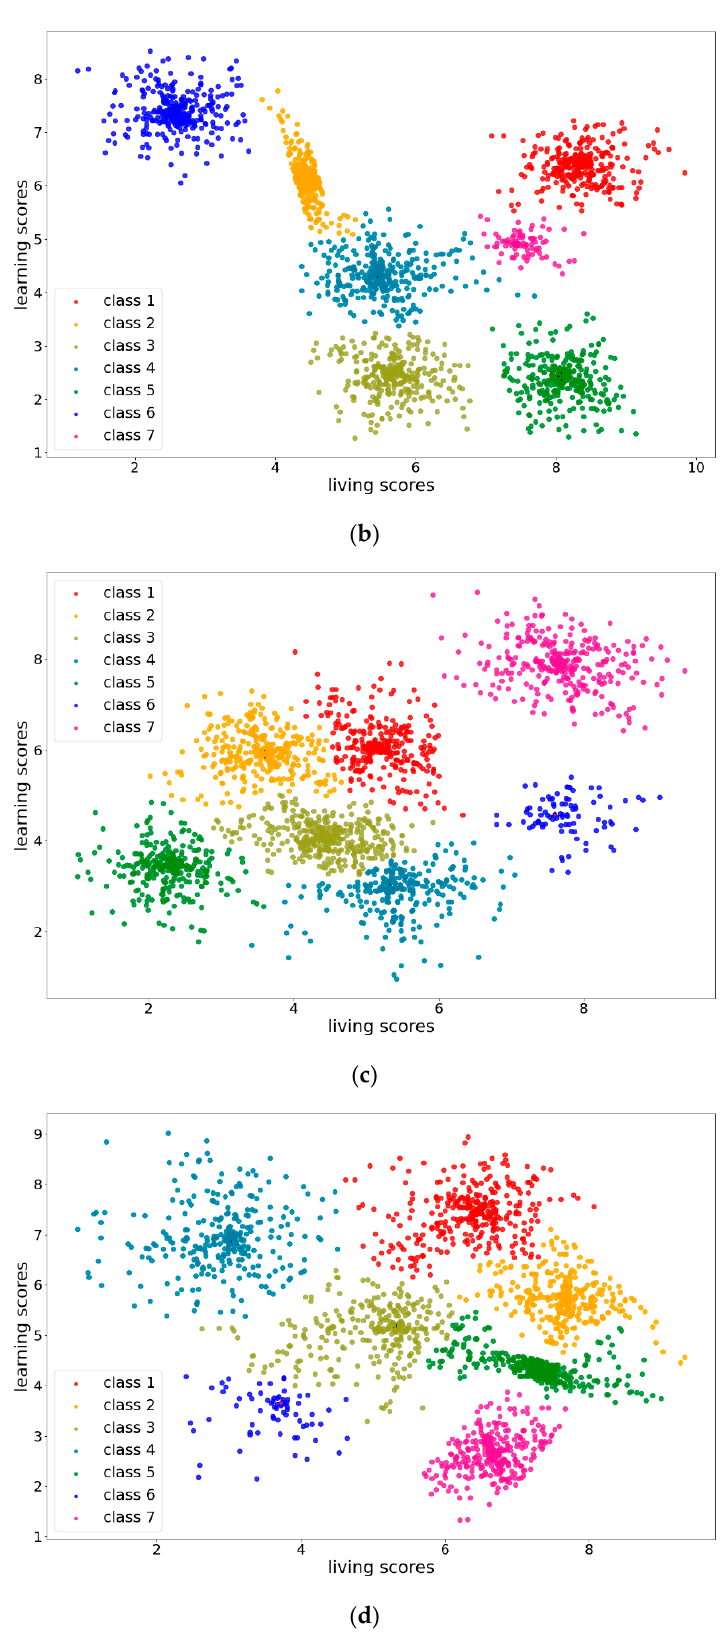
Figure 15. The results graph of the CFSFDP algorithm: ( a ) S1; ( b ) S2; ( c ) S3; and ( d ) S4.